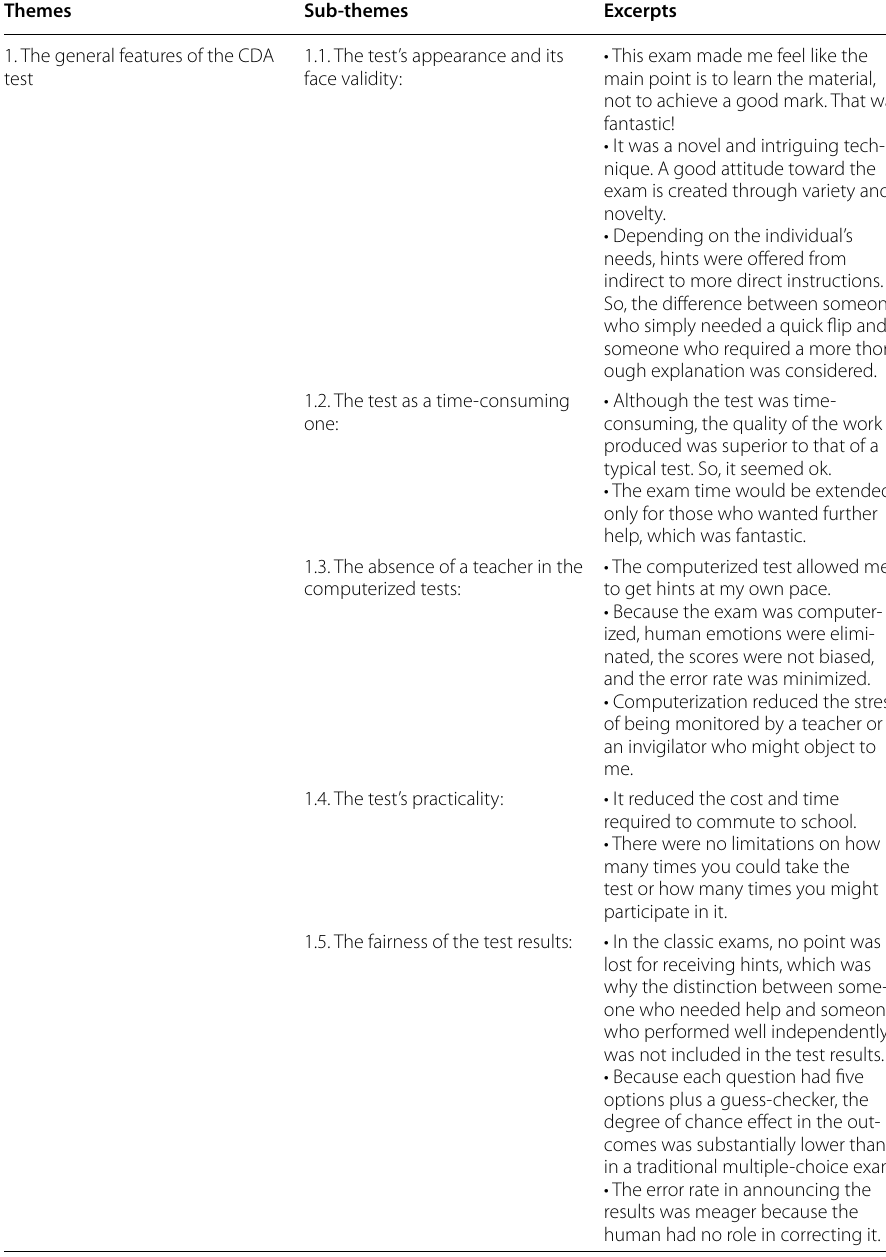
Table 2 Content analysis of the data gathered through the